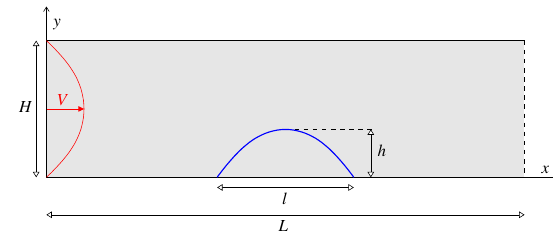
Figure 1: Sketch of the problem definition. The channel has length L = 300 and H = 60 (in lattice